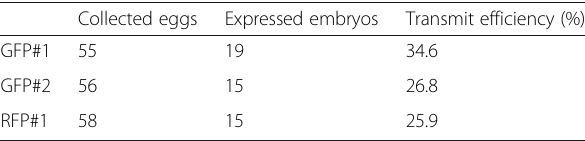
Table 3 Germ-line transmition efficiency of F0 individuals harboring GFP or RFP in the gap43 locus Collected eggs Expressed embryos